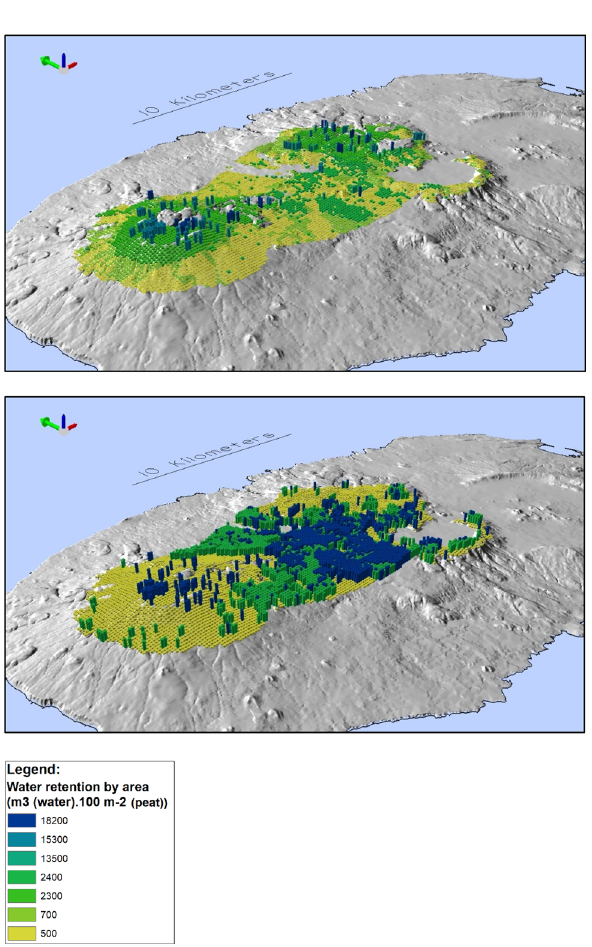
Fig. 10 Tridimensional representation of water retention by area (m 3 (water). 100 m −2 (peat)), actual (top) and potential (bottom), for Flores Island (Digital Model elevation is proportional to the bidi- mensional